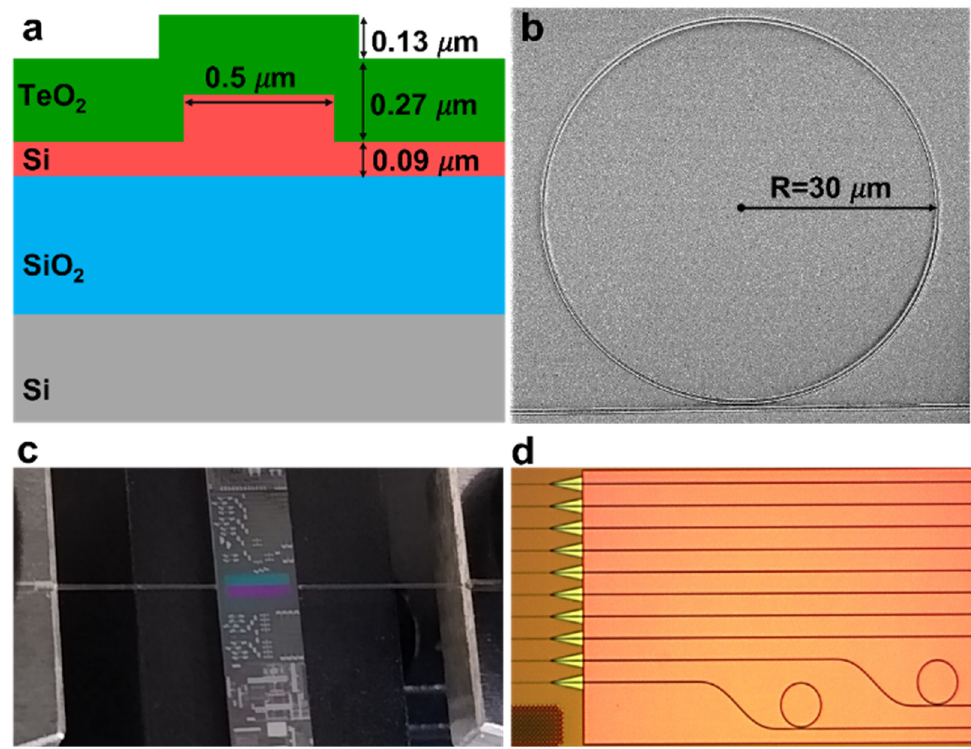
Figure 1. ( a ) Cross-section profile of the TeO 2 -coated Si microring showing the microring structure. ( b ) Top-view SEM image of a TeO 2 -coated Si microring resonator. ( c ) Photograph of the coupling setup during measurement showing the SOI chip with window opening for TeO 2 post-processing deposition. ( d ) Microscopic image of the open window microring resonator structure.